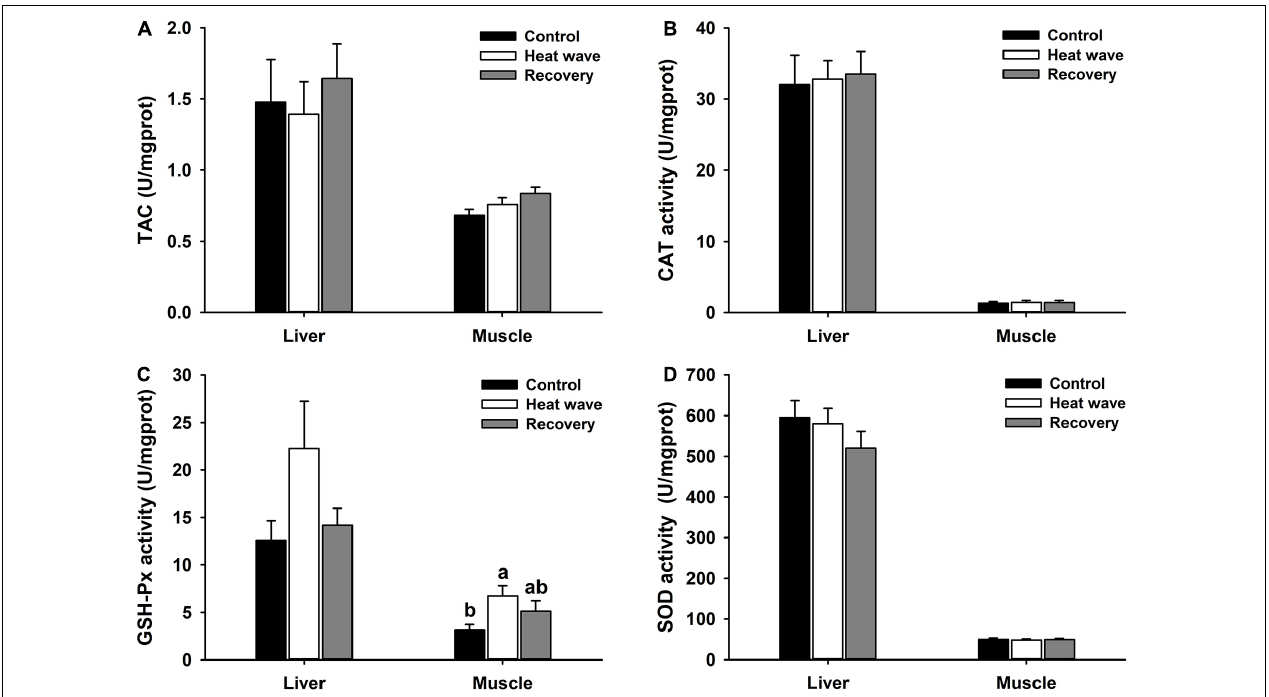
FIGURE 2 | Effects of heat wave on TAC (A) , CAT activity (B) , GSH-Px activity (C) , and SOD activity (D) in the liver and muscle of Mauremys mutica. Data were represented as mean ± standard error (SE).